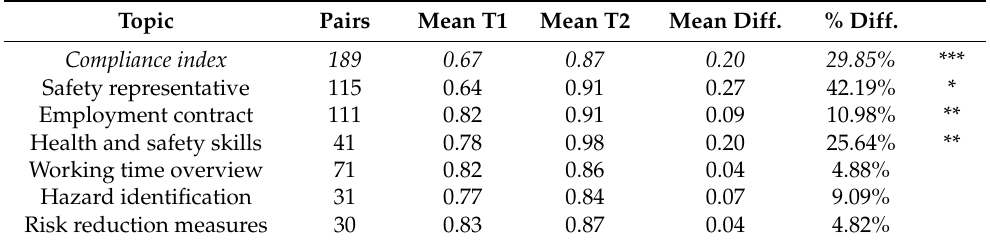
Table 6. Scores for compliance index and checkpoints for companies with managers that lack OSH training at T1 but who have undergone OSH training at T2 (Study 3), including paired sample t -test. Topic Pairs Mean T1 Mean T2 Mean Diff. % Diff. Compliance index 189 0.67 0.87 0.20 29.85% *** Safety representative 115 0.64 0.91 0.27 42.19% * Employment contract 111 0.82 0.91 0.09 ** Health and safety skills 41 0.78 ** Working time overview 71 0.82 0.86 0.04 4.88% Hazard identification 31 0.77 0.84 0.07 9.09% Risk reduction measures 30 0.83 0.87 0.04